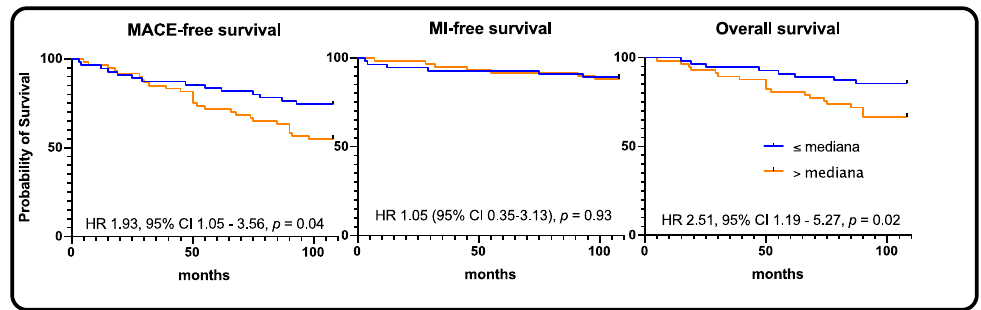
Figure 3. Chronic coronary syndrome population—Kaplan–Meier curves for MACE, myocardial infarction, and all-cause death, respectively.